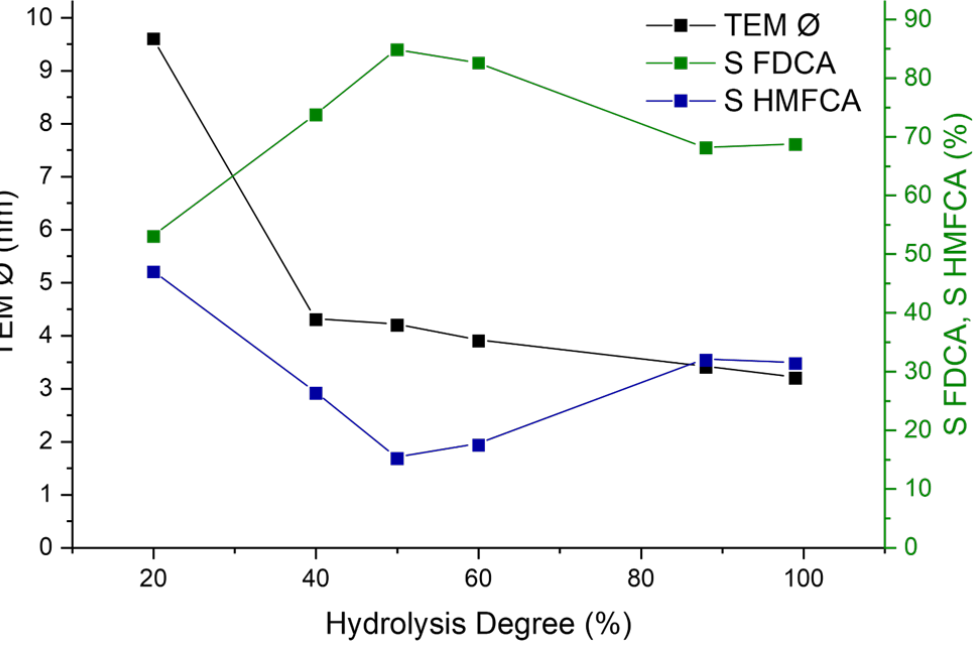
Figure 2. Correlation between mean particle diameter (TEM Ø, in black) and FDCA selectivity (S FDCA, in green) while changing the hydrolysis degree.